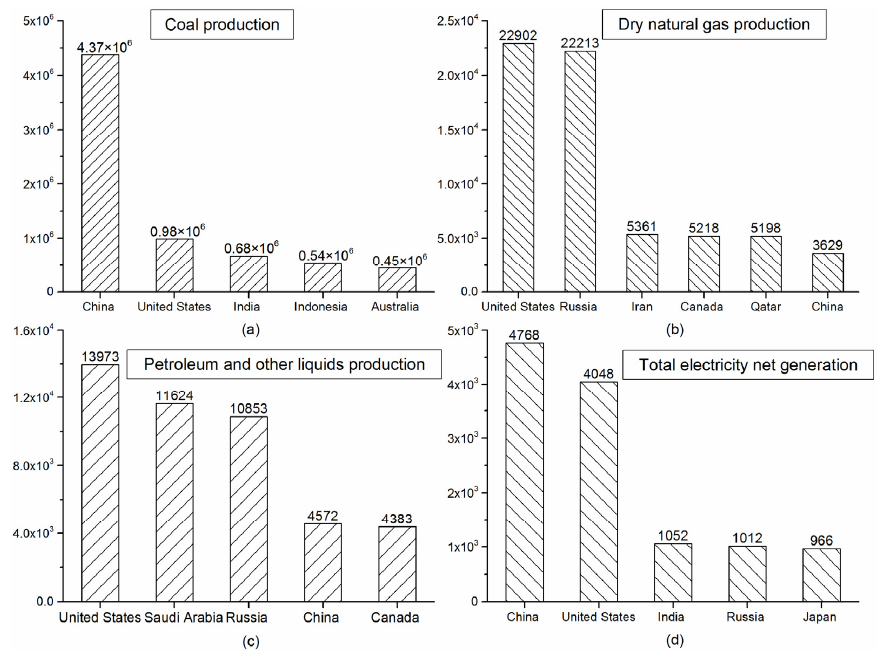
Figure 1. Top-ranked energy production countries in recent years. ( a ) Top five coal production countries in 2013 (thousand short tons); ( b ) Top five dry natural gas production countries and their comparison with China in 2011 (billion cubic feet); ( c ) Top five petroleum and other liquids production countries in 2014 (thousand barrels per day); ( d ) Top five total electricity net generation countries in 2012 (billion kilowatt-hours) *. * To guarantee accuracy, only the most recent years with sufficient data were analyzed.